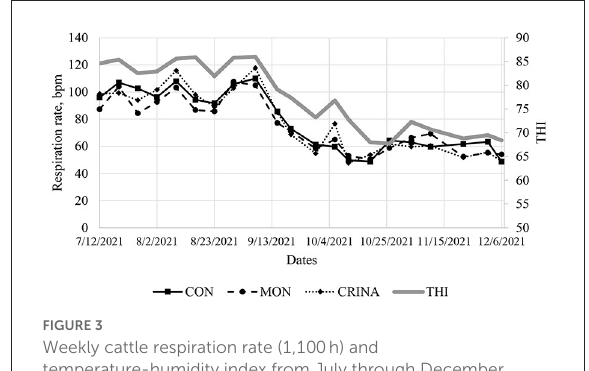
FIGURE3 Weekly cattle respiration rate (1,100h) and temperature-humidity index from July through